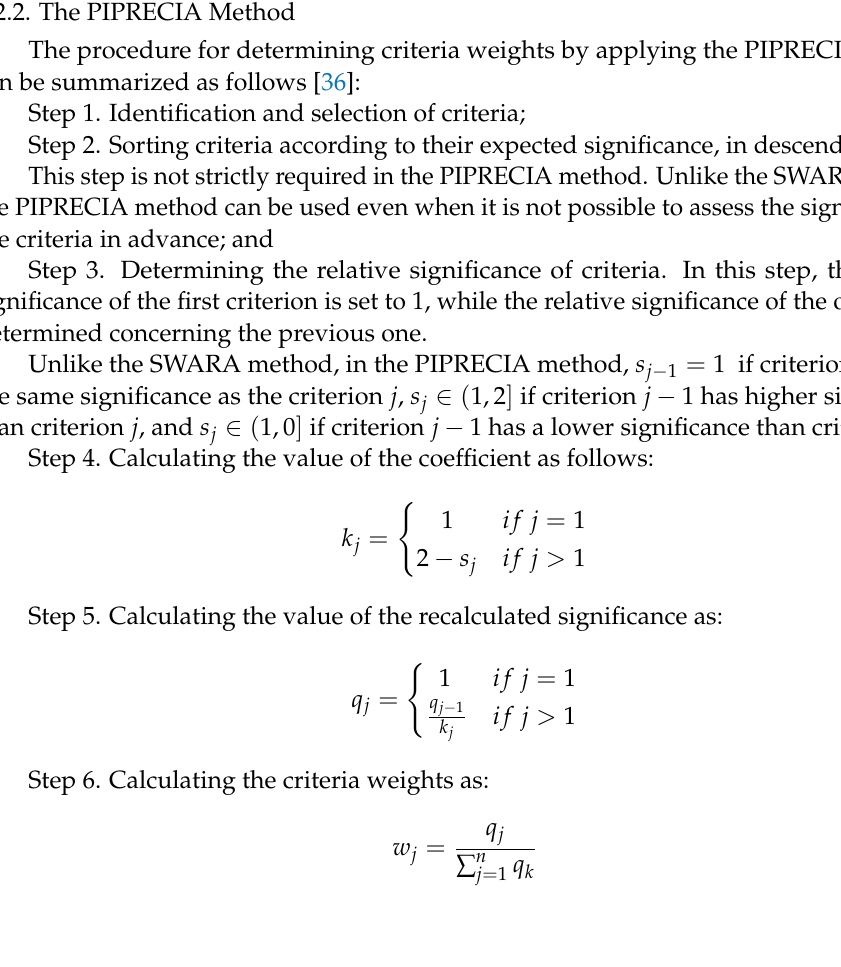
Figure 2. Flowchart of the SWARA method.